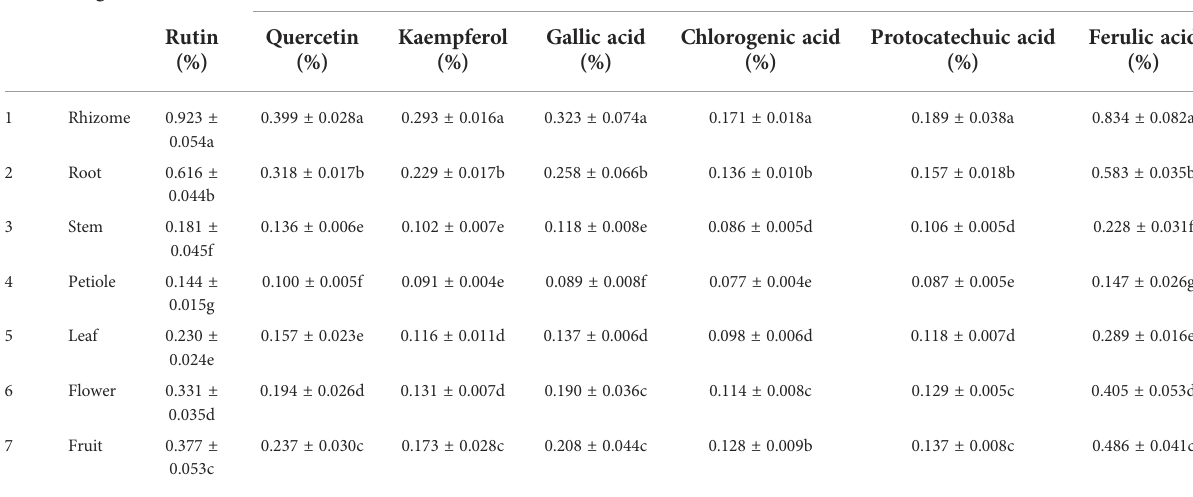
TABLE 1 The contents of phenols including fl avonids and phenolic acids in different organs of S. hexandrum. Code Organ